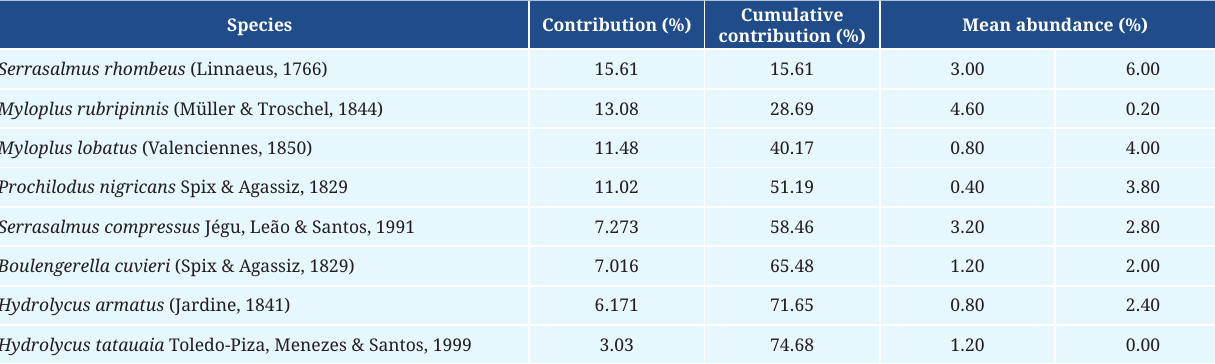
Cumulative Mean abundance contribution (%)